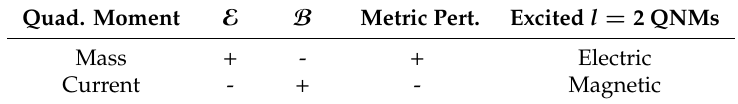
Table 2. The parity of various quantities generated by the mass and current quadrupole moments. Quad. Moment E B Metric Pert. Excited l = 2 QNMs Mass + - + Electric Current - + -